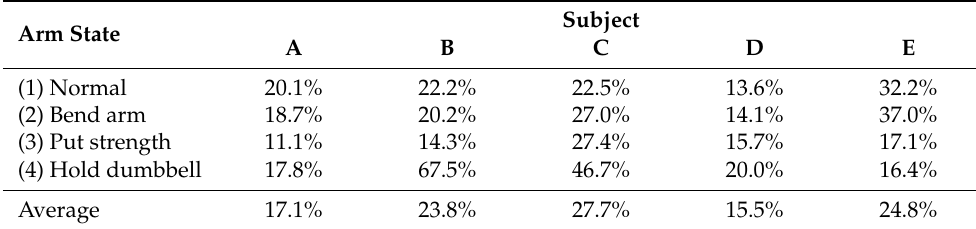
Table 4. Error rate [%] of RMS for four muscle activity